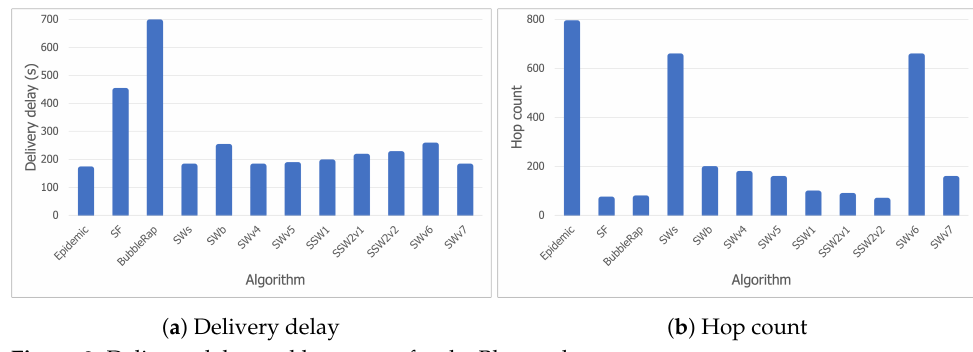
Figure 9. Delivery delay and hop count for the Bluetooth